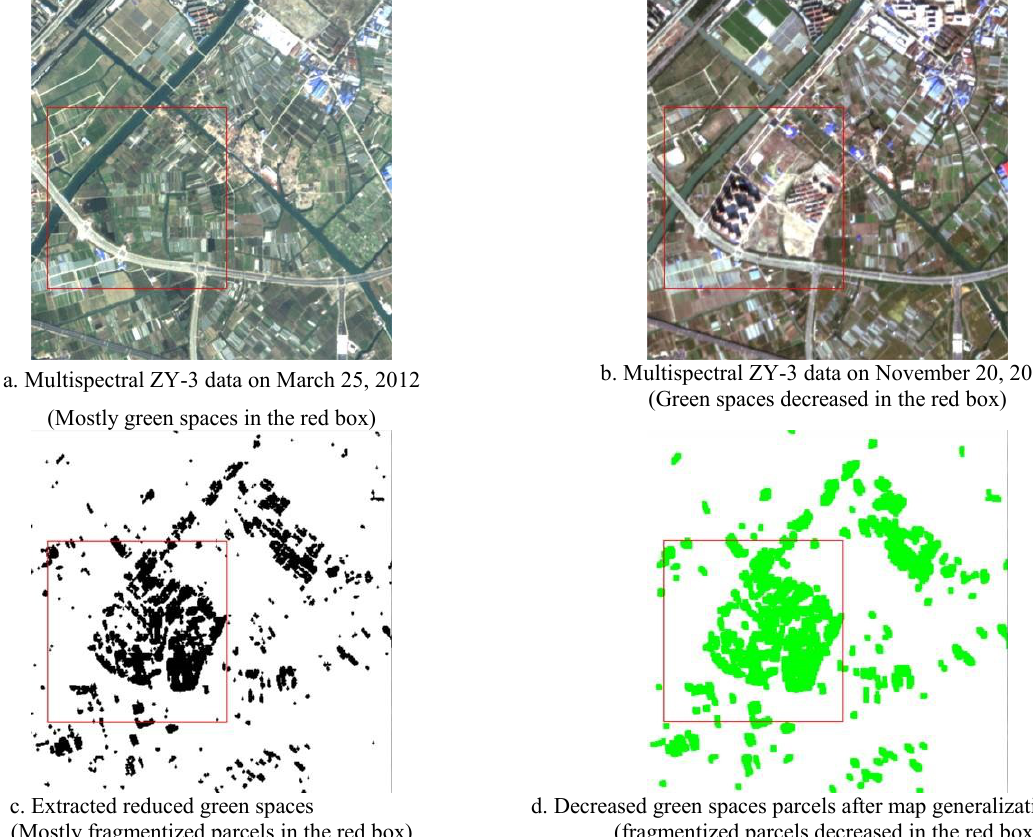
Figure 5. A scheme showing the map generalization of the decrease of green spaces in